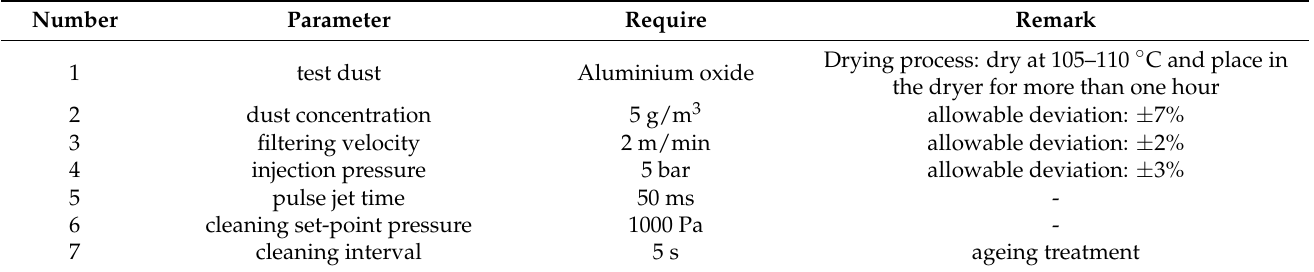
Figure 2. Standard dust particle size distribution. Table 2. Standard test